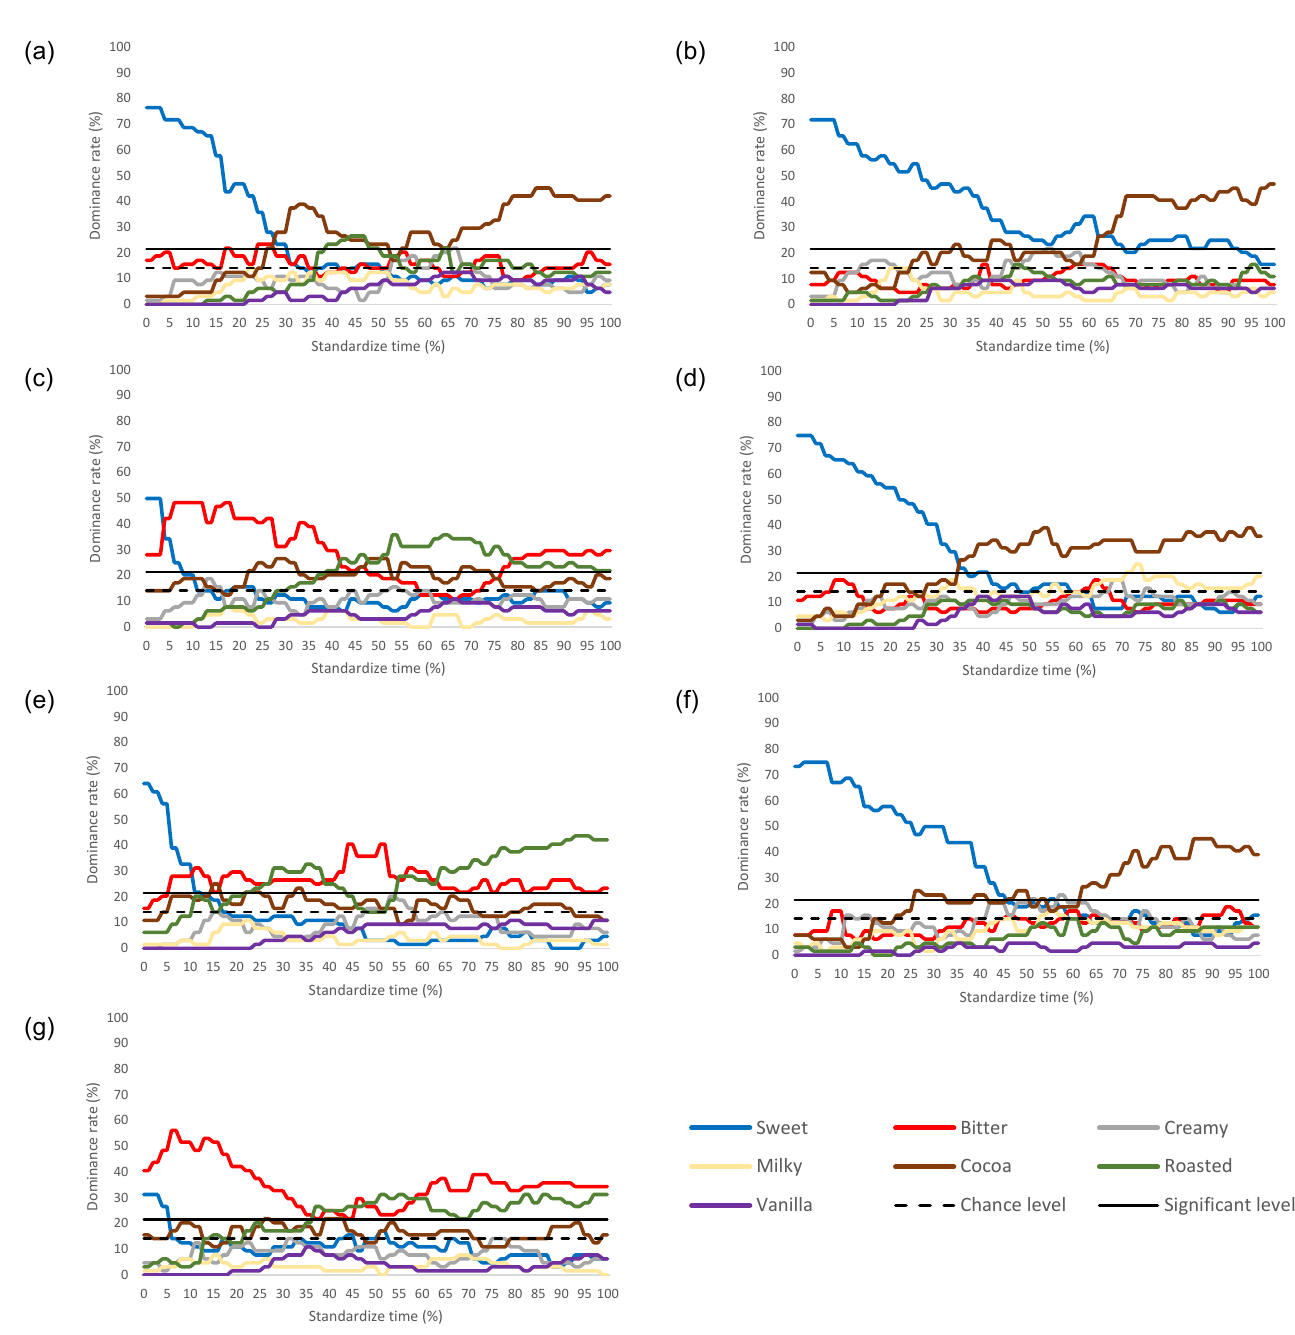
Figure 3. TDS dominance curves for chocolate ice cream consumed under: ( a ) silence; ( b ) liked music (LM); ( c ) disliked music (DM); ( d ) pleasant sound (PS); ( e ) unpleasant sound (US); ( f ) LMPS; ( g ) DMUS conditions. Panel dominance rates (%) of the seven sensory attributes presented in the TDS sessions are expressed as the % of standardised time. According to Pineau et al. [27], the curves represent the average dominance rates for all the panels (N = 64). The calculated chance and significance levels were between 14.29% and 21.48%, respectively.